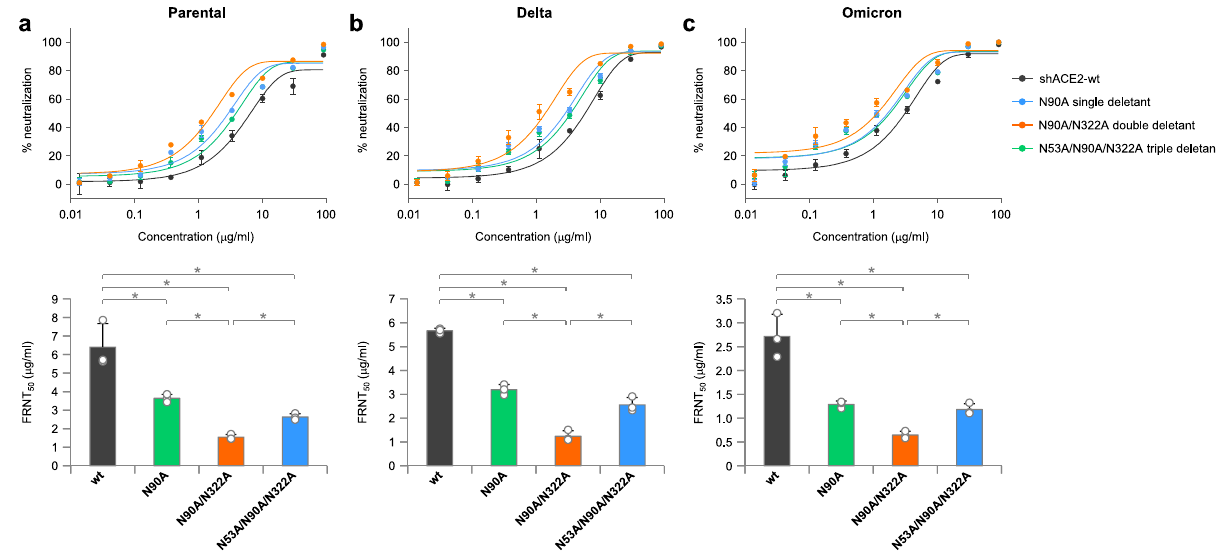
Fig. 5 Glyco-optimized shACE2 forms possess improved neutralizing activities against CoV2 Parental, Delta and Omicron. ( a – c , upper) Neutralization kinetics against CoV2 Parental ( a ), Delta ( b ), and Omicron ( c ) using shACE2-wt and the indicated glyco-modi fi ed shACE2 variants at serially diluted concentrations (0.0137 to 90 μ g/ml). ( a – c , lower) Neutralizing activities of shACE2 are shown as the 50% focus reduction neutralizing titers (FRNT 50 ) calculated by fi tting the kinetic data of the upper panel. Each data point is the mean ± SD from three independent experiments. Statistically signi fi cant differences are shown as * P < 0.05.